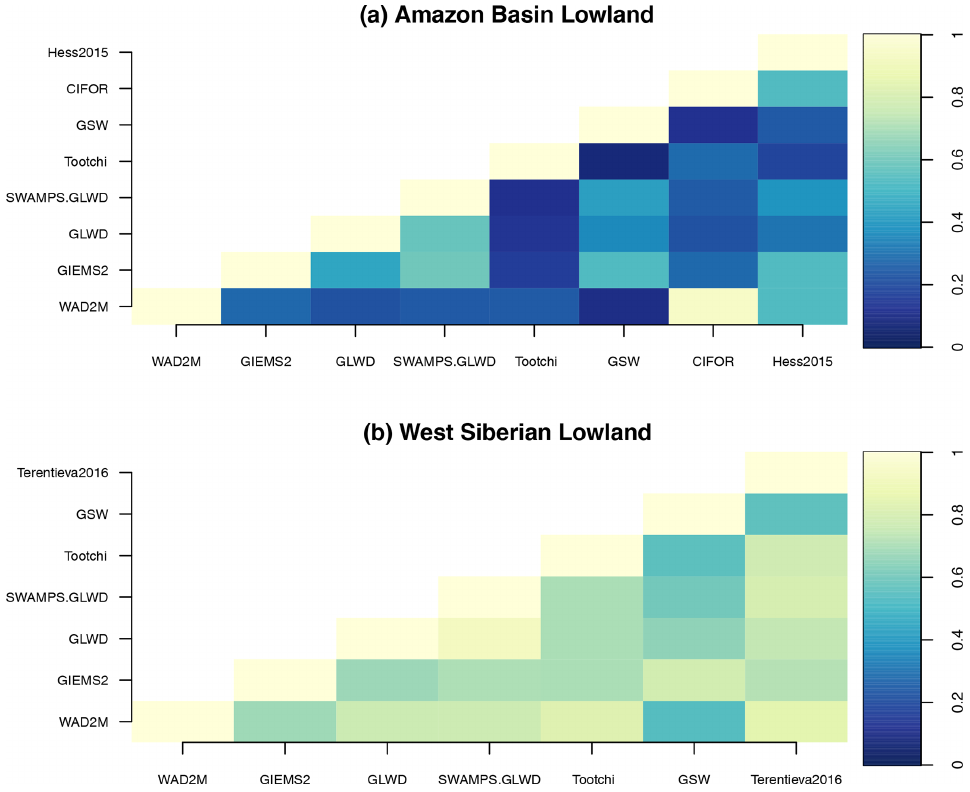
Figure 6. Matrix of kappa coefficient for each pairwise comparison for (a) Amazon Basin lowlands and (b) West Siberian lowlands. The Hess et al. (2015) and Terentieva et al. (2016) data represent two independent regional datasets. All of the datasets in (b) were masked by the map of Terentieva et al. (2016), which is available for the taiga forest zone; hence the calculation of the kappa coefficient excludes the arctic tundra zone (latitude > 65 ◦